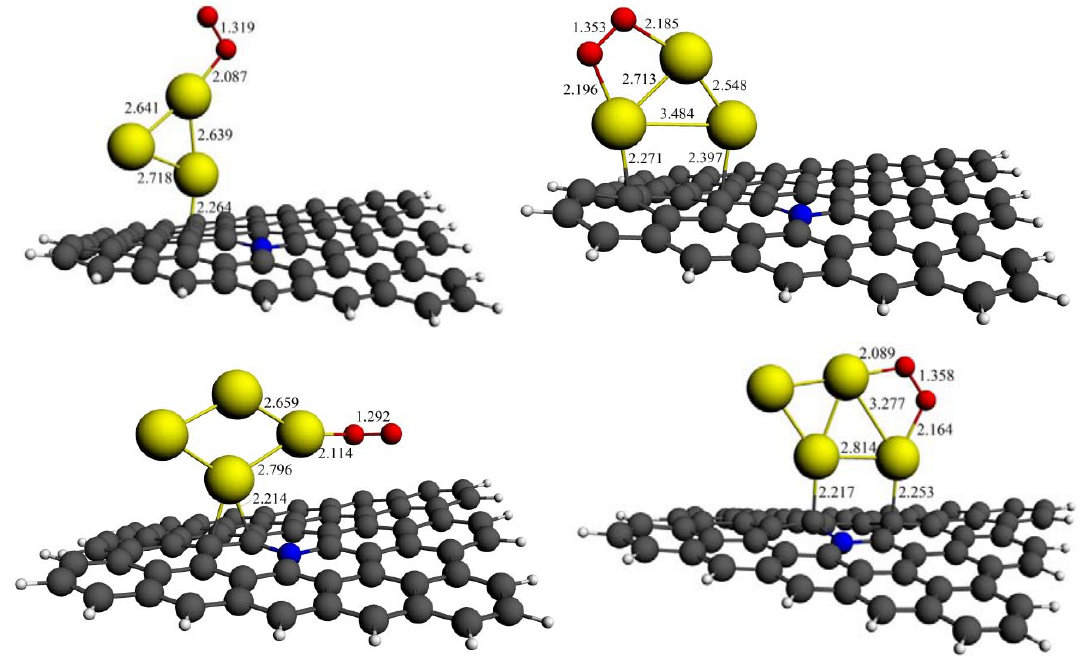
and Au cluster, respectively (distances are in angstrom). 3 4